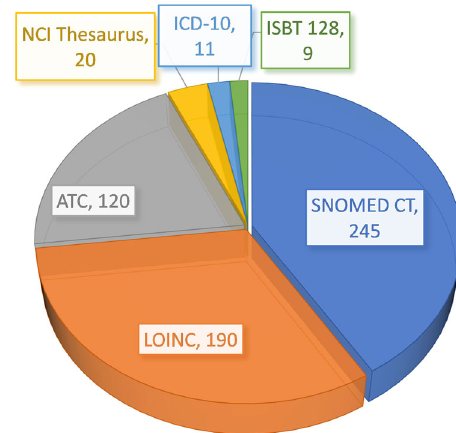
Fig. 3 Unique standard codes. Overview of unique codes from recognized international standard terminologies and classi fi cations assigned to common variables used in the LTS and FP studies ’ electronic Case Report